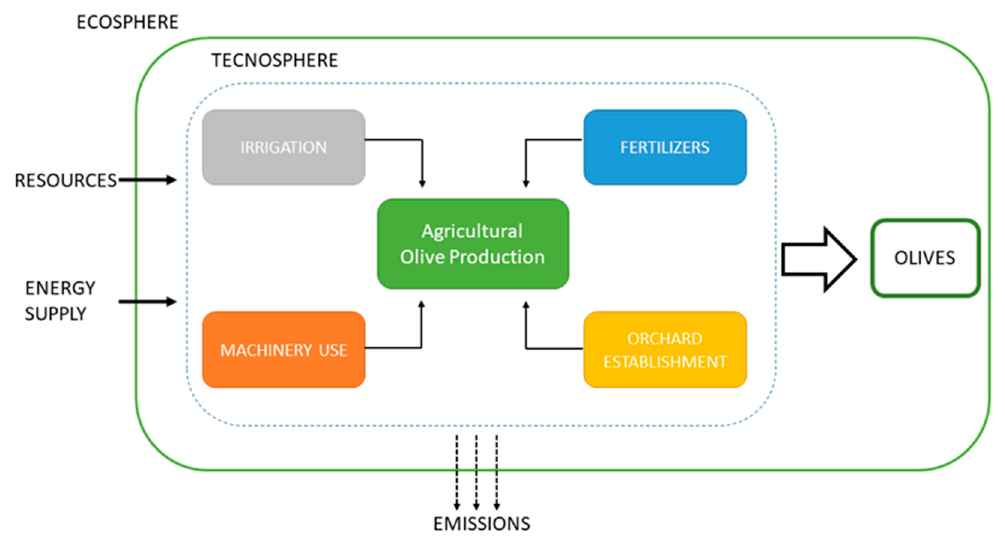
Figure 1. General flow diagram of olive production systems in Italy.